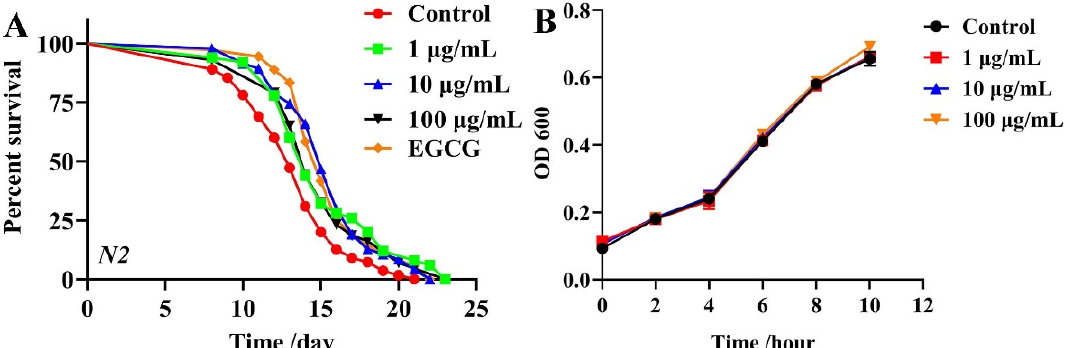
Figure 1. Effects of TG on the lifespan of C. elegans and E coil . OP50. ( A ) Survival of C. elegans treated with 0.1% DMSO (control); 500 μ M EGCG (positive control) and 1, 10 and 100 μ g/mL TG. TG produced its optimal effects at 10 μ g/mL, extending the lifespan of C. elegans by up to 9.11% ± 2.04%, n = 3 (~80 individuals per group), Kaplan–Meier survival analysis with the log-rank test. ( B ) OP50 in LB medium containing 1, 10 and 100 μ g/mL TG. TG did not inhibit the growth of OP50 during any bacterial growth phase. Data were analyzed by a Student’s t -test using GraphPad 8. Values are presented as the mean ± SEM.